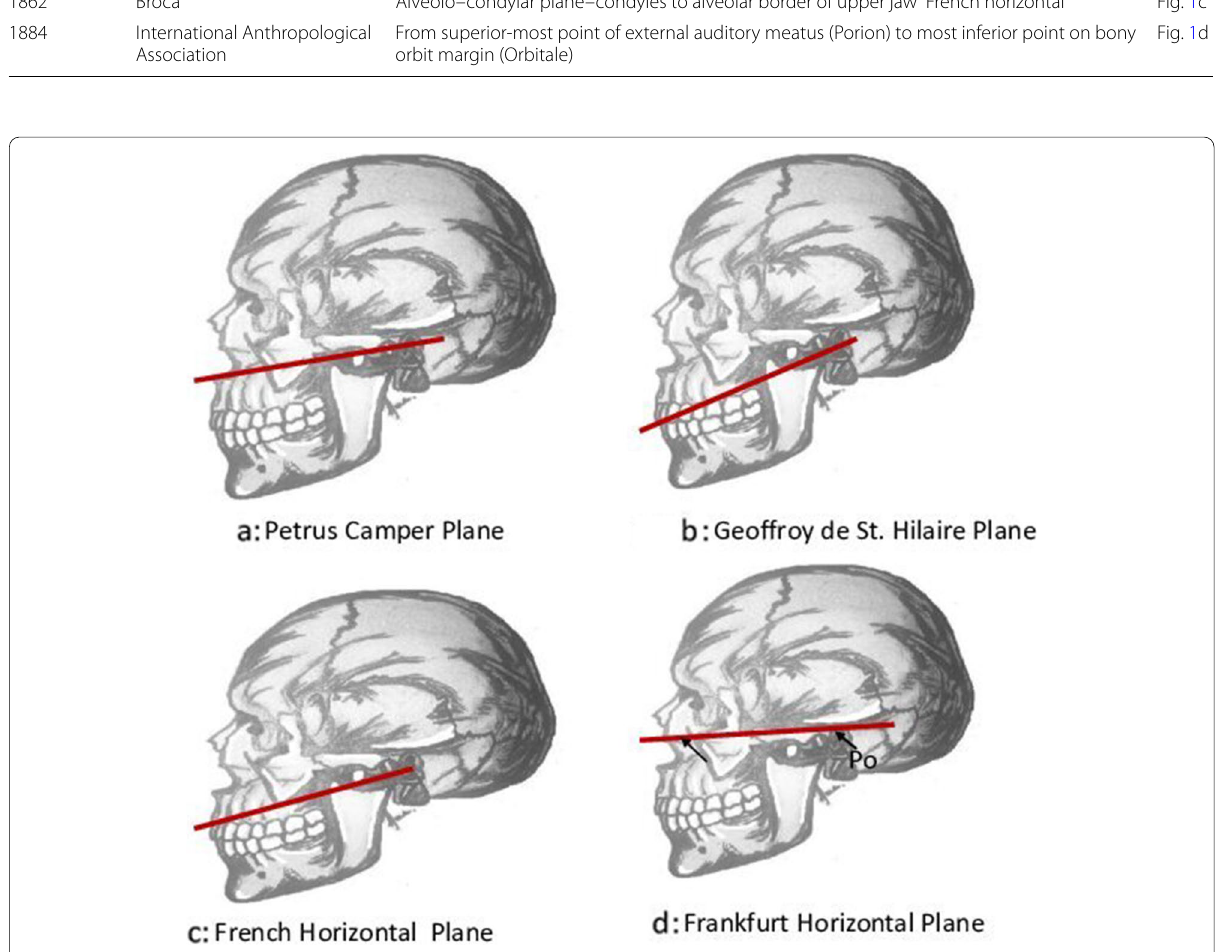
Fig. 1 Reference planes for skull. a Petrus Camper plane. b Geoffroy de St. Hilaire plane. c French horizontal plane. d Frankfurt horizontal